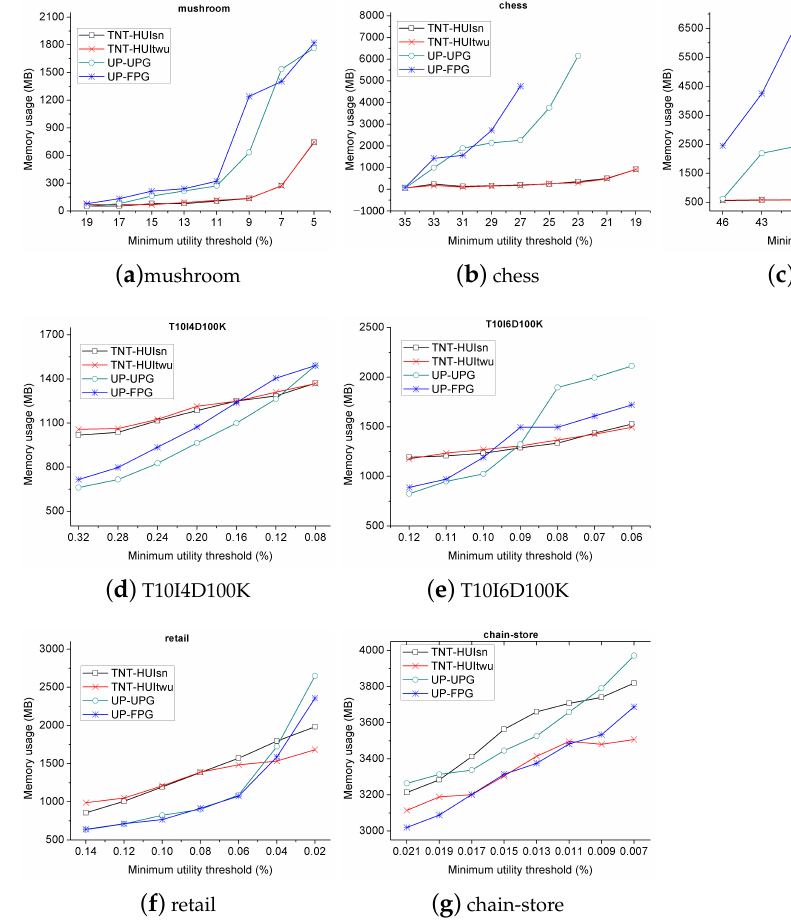
Figure 7. Comparison of maximum memory